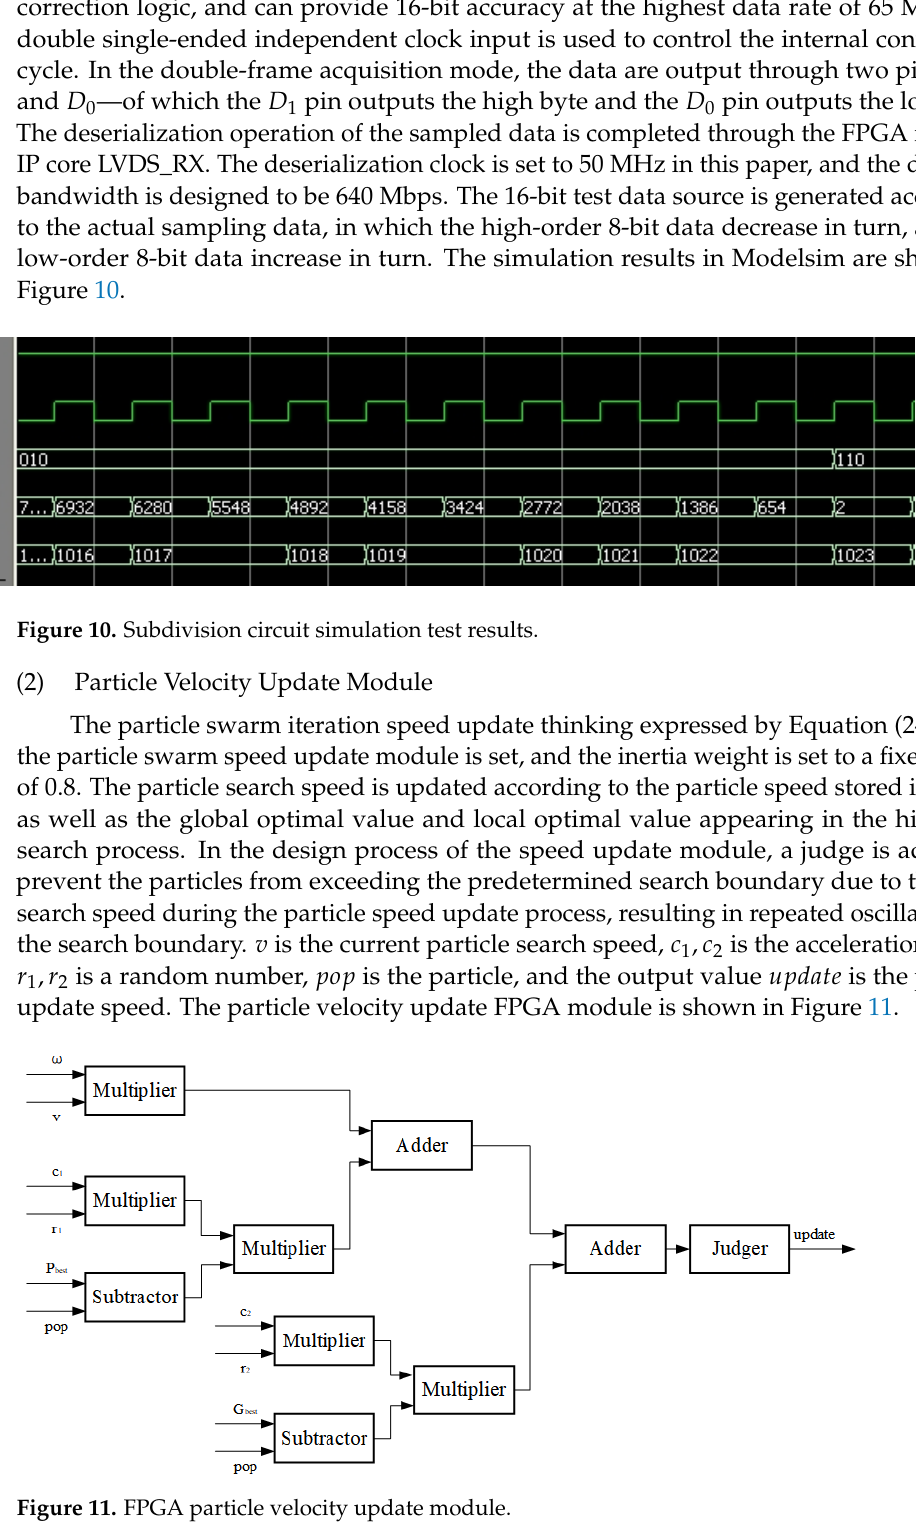
Figure 11. FPGA particle velocity update module.